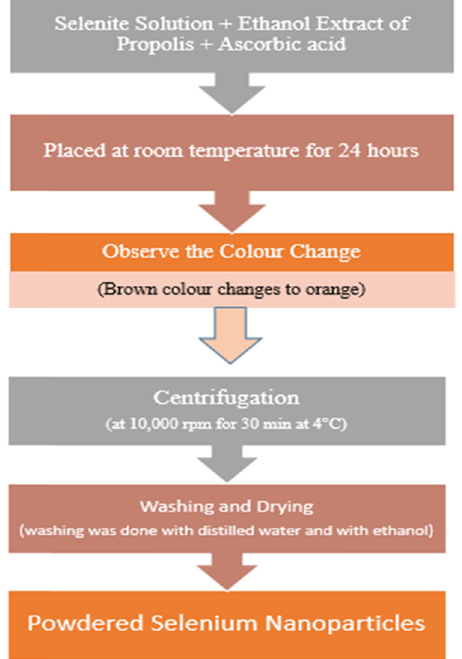
Figure 3: Schematic representation for the synthesis of selenium nanoparticles from ethanolic extract of